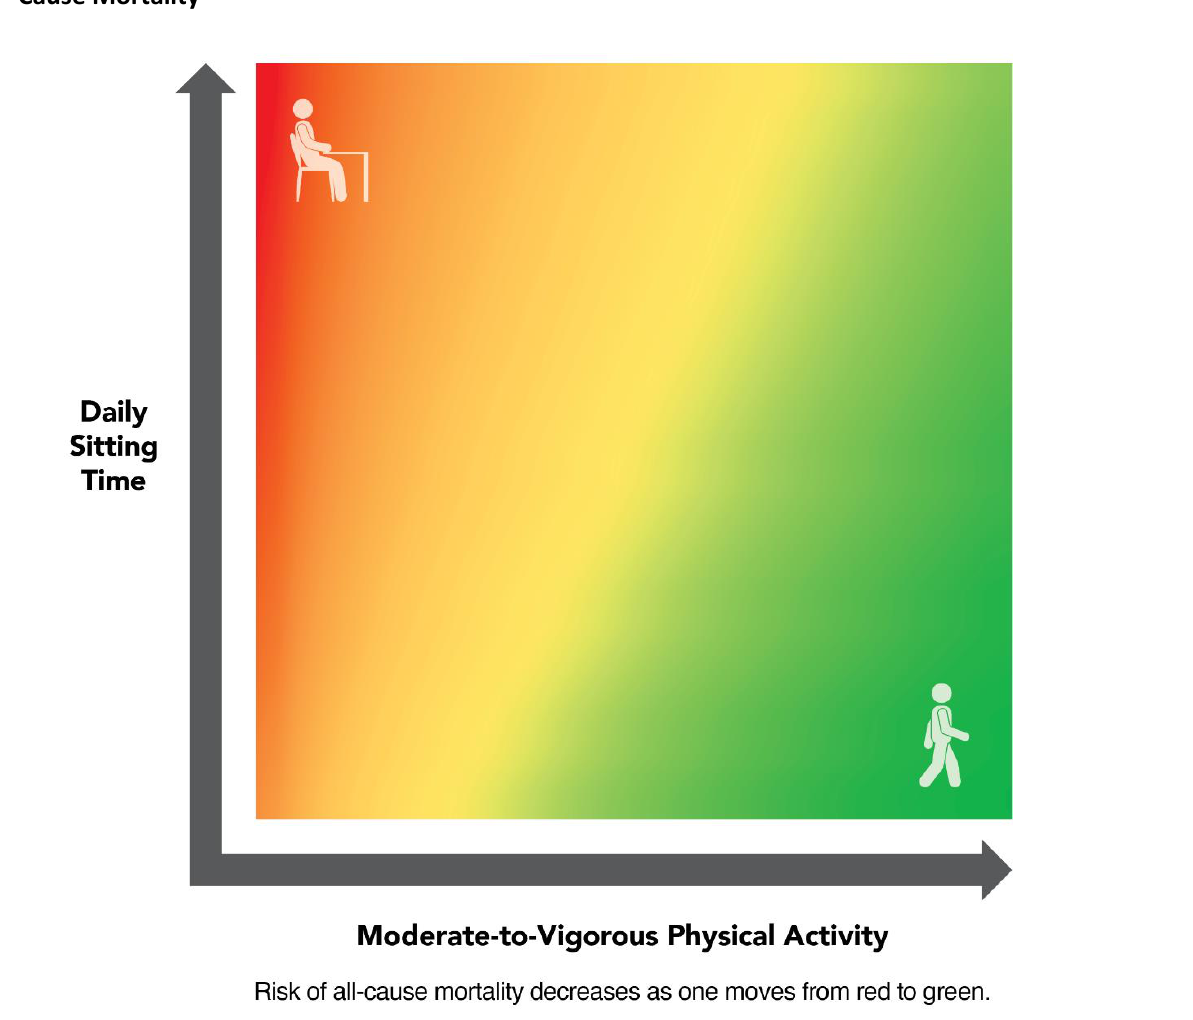
Figure D-2. Relationship Among Moderate-to-Vigorous Physical Activity, Sitting Time, and Risk of All- Cause